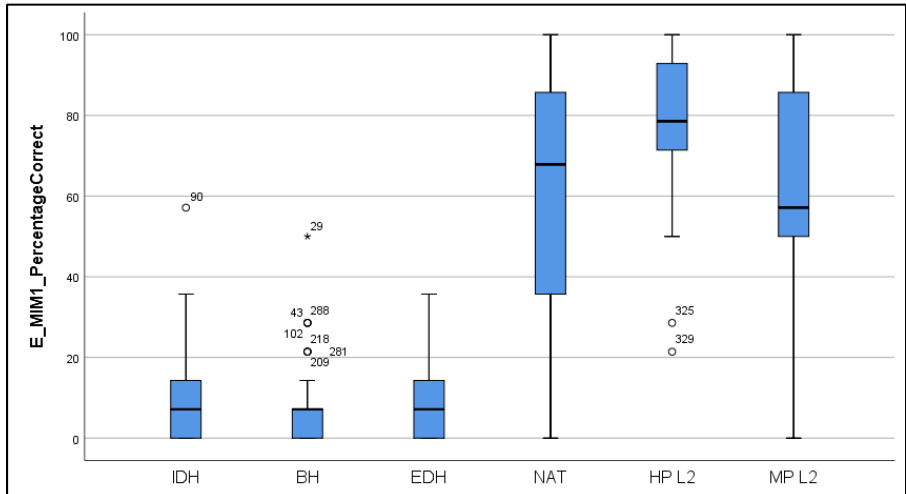
Figure 3. E-MIM Subtest 1 (Det+N): Child and adult participants’accuracy by language back- ground. IDH = Child, Irish-Dominant Home; BH = Child, Bilingual Home; EDH = Child, Eng- lish-Dominant Home; NAT = Adult L1/Native Speaker; HP L2 = Adult Highly Proficient L2 speaker; MP L2 = Adult Moderately Proficient L2 speaker. (* = extreme value).